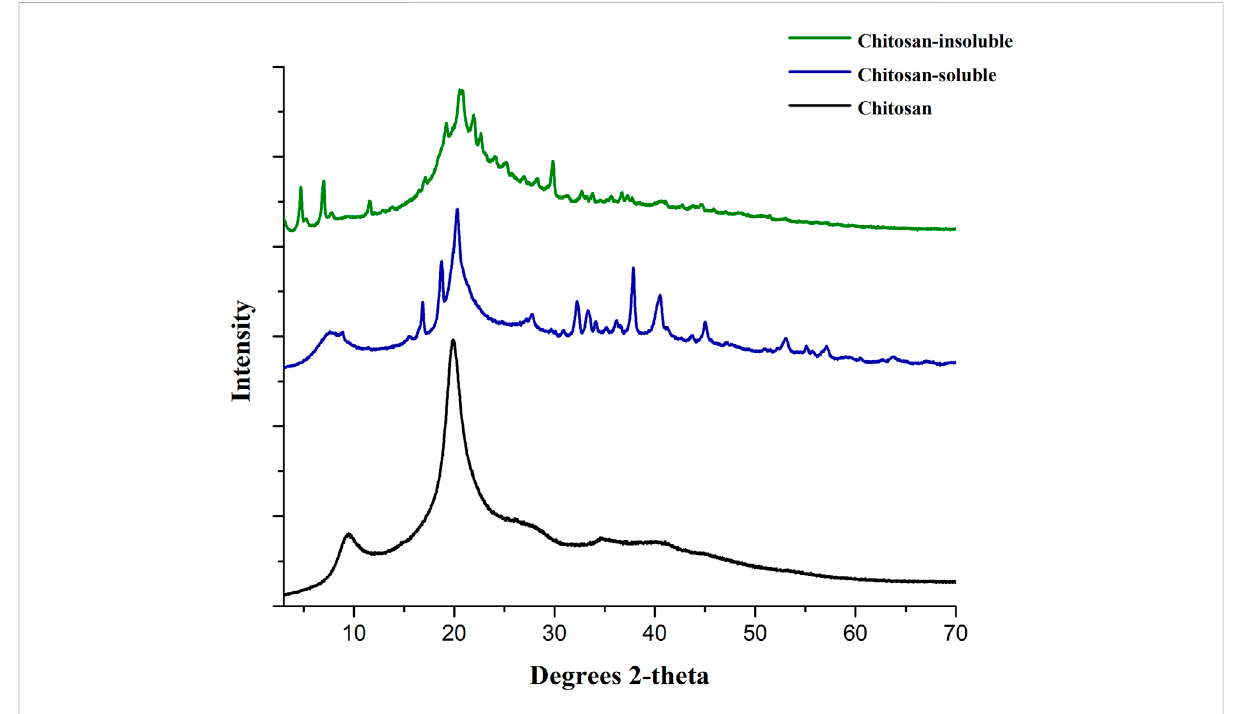
FIGURE 2 X-ray diffraction patterns (XRD) of chitosan, chitosan-soluble, and